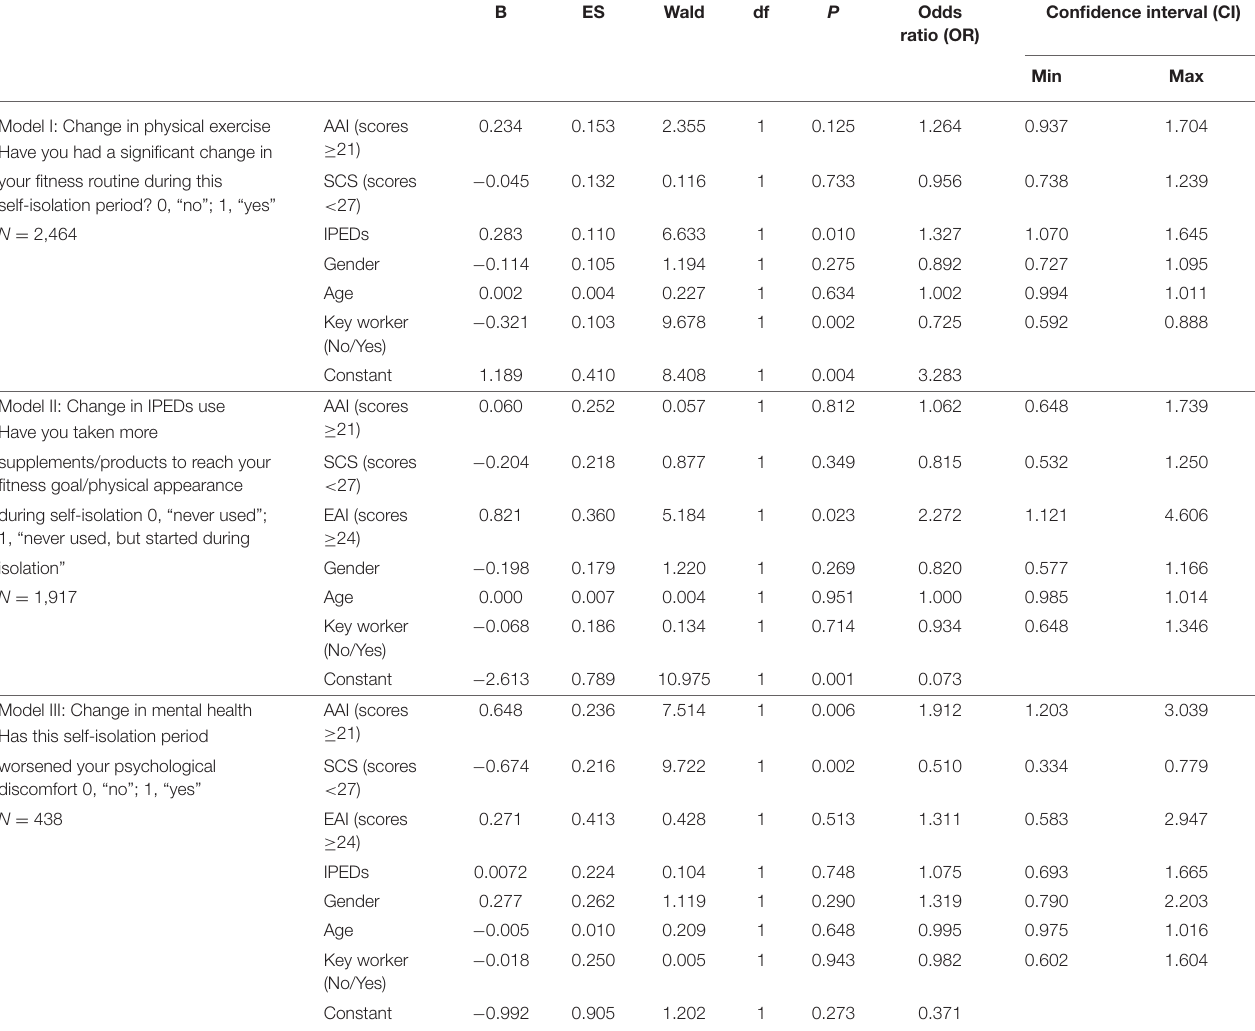
B ES Wald df P Odds